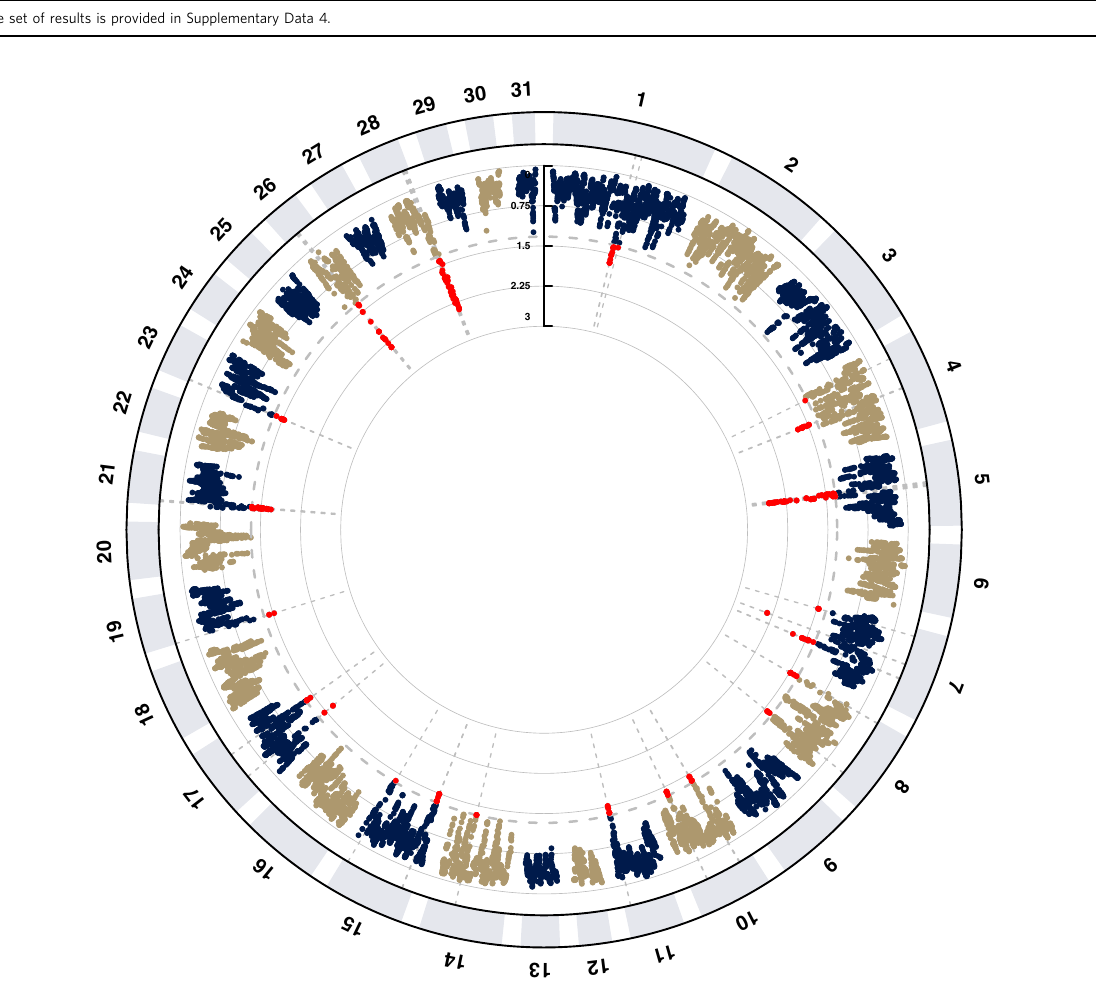
Fig. 4 Manhattan plot for the results of the composite selection signals (CSS) analysis to detect targets of selection among Mongolian Racing (MonR) horses ( n = 24 horses) when compared with other breeds ( n = 549 horses). The results were obtained by averaging the CSS scores of SNPs within 100 kb sliding windows. The dashed grey line indicates the genome-wide (1% SNPs) threshold of the empirical scores and the top SNPs are indicated by red